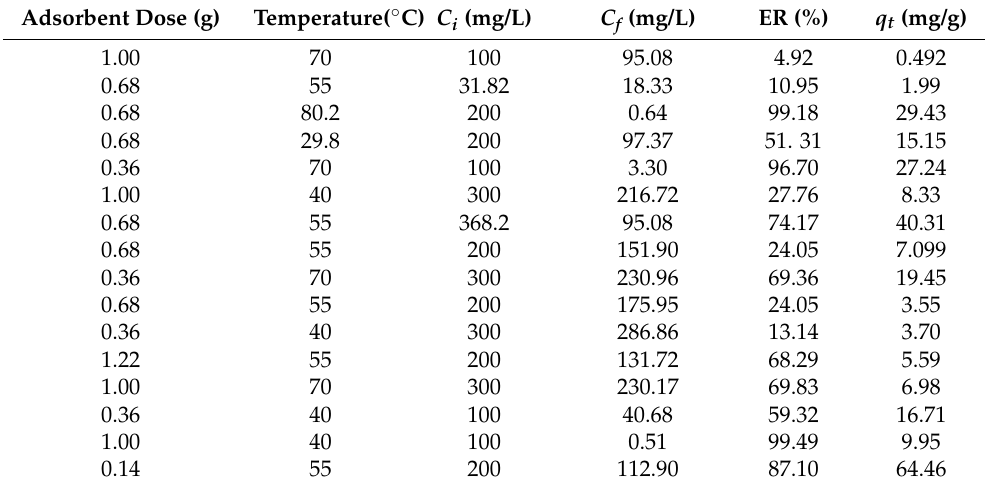
Table 4. Adsorption capacity of Cr (VI) on residual plantain pulp at different conditions of tempera- ture, adsorbent dose and initial concentration.